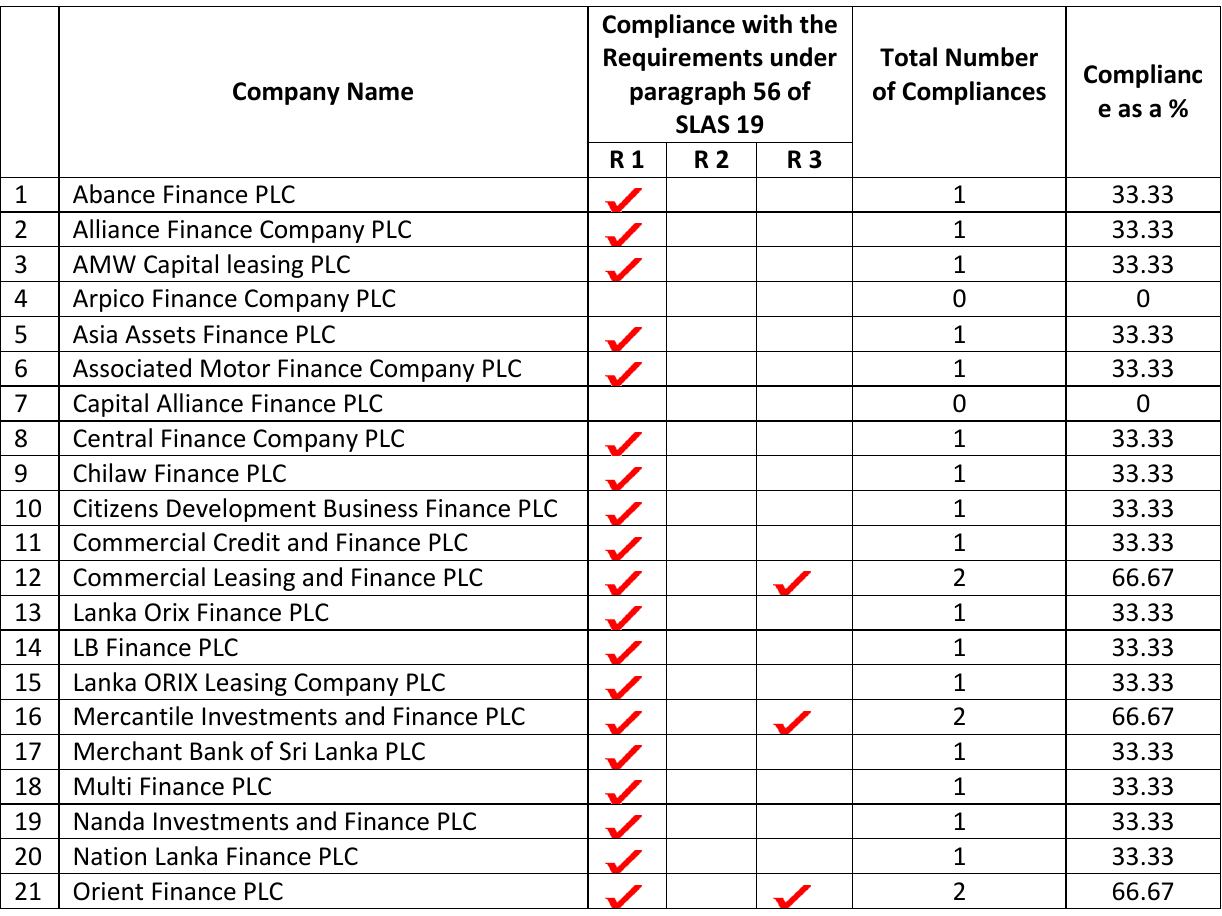
Table 02: Special Evaluation Schedule of compliance for requirements under paragraph 56 of LKAS